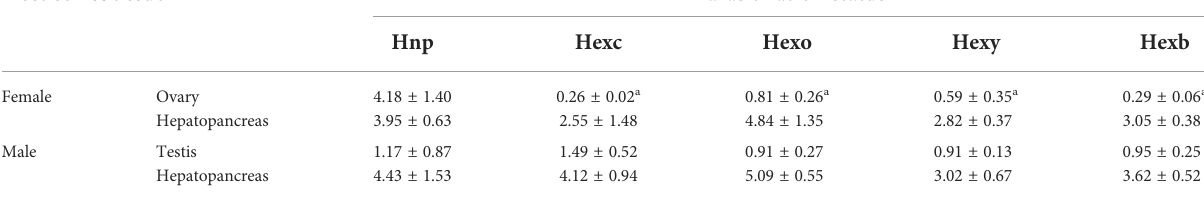
TABLE 1 Effect of parasitism of Polyascus planus on the tissue weight of the host thukuhar shore-crab Metopograpsus thukuhar . Host sex &